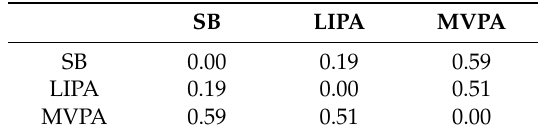
Table 2. Compositional variation matrix of movement behavior